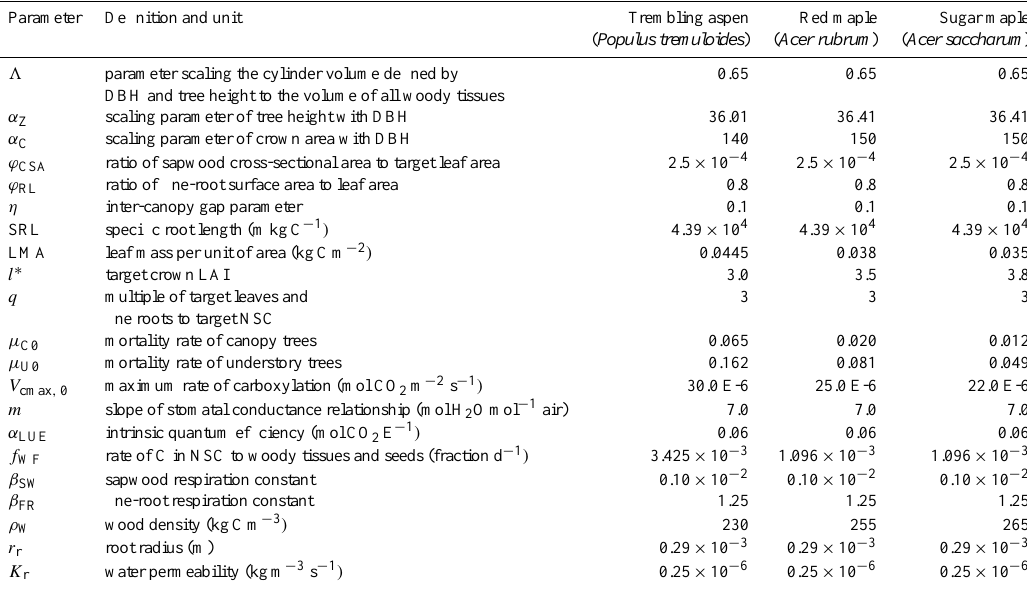
Table C3. Parameters of the three species (succession tests).